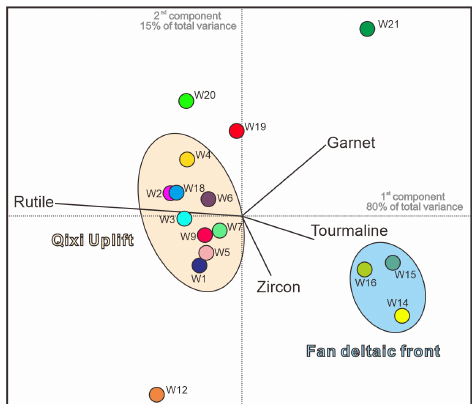
Figure 12. The rutile, garnet, tourmaline and zircon contents of beach-bar sandstones of Mbr2 stage in the Weixinan sag. The concentration of heavy minerals is controlled by sediment provenance. The beach-bar sediments were from the fan deltaic front and the Qixi uplift. The compositional biplot [54], drawn using CoDaPack software [55], displays multivariate observations (points) and variables (rays). The length of each ray is proportional to the variance of the corresponding element in the data set. If the angle between two rays is close to 0 ◦ , 90 ◦ , or 180 ◦ , then the corresponding elements are directly correlated, uncorrelated, or inversely correlated, respectively. Data for the biplot are provided in supplementary